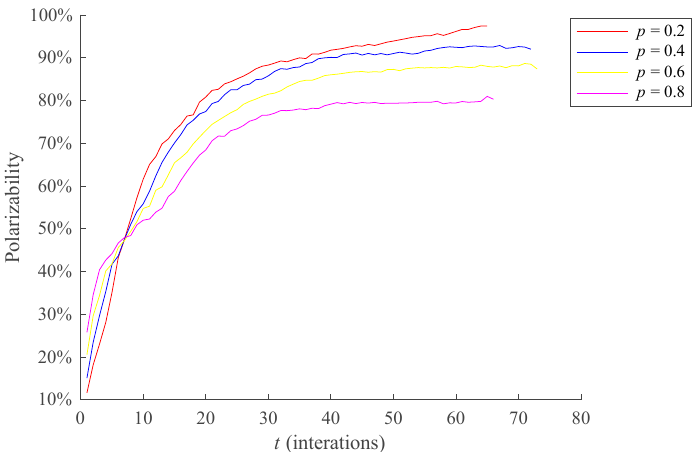
Figure 10. The influence of different p on the polarization process of public